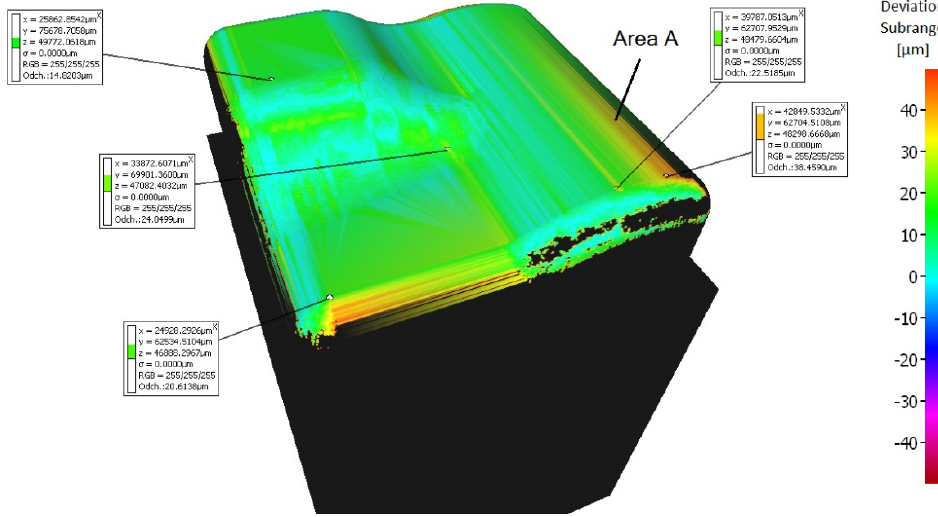
Figure 14. Comparison of the initial model with the workpiece after 5-axis milling (tool inclination β f = 15°, β n = 5°).